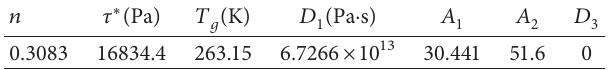
Table 1: Cross-WLF viscosity model parameters of